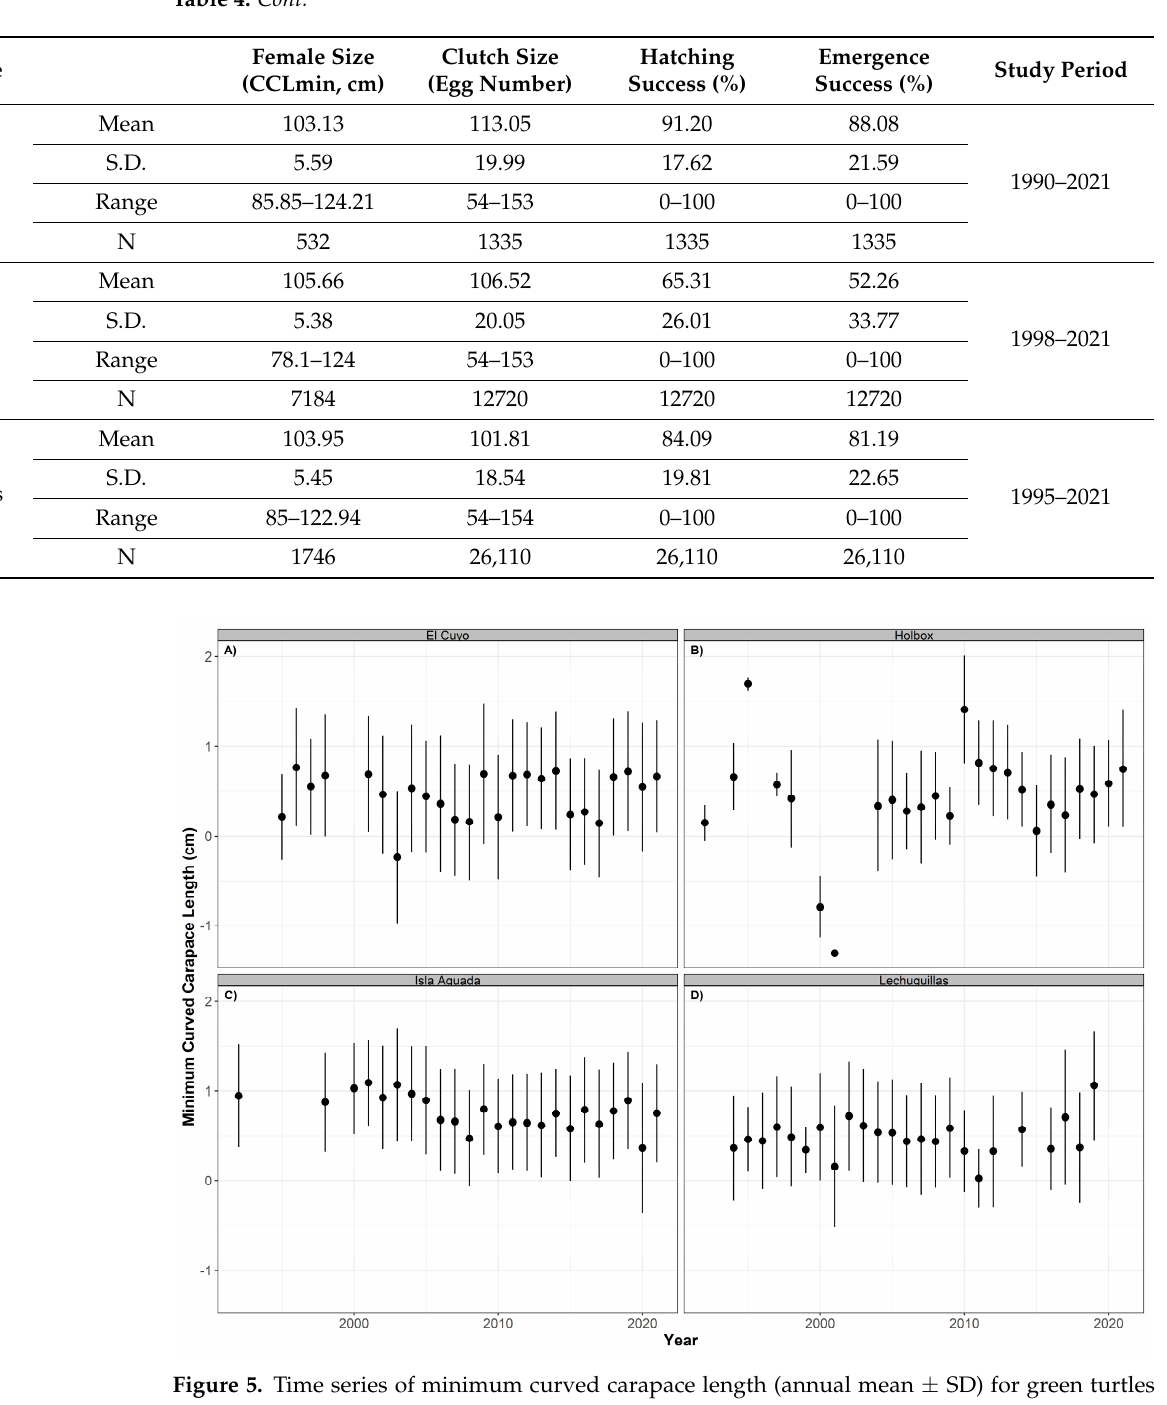
Figure 5. Time series of minimum curved carapace length (annual mean ± SD) for green turtles ( Chelonia mydas ) nesting at El Cuyo ( A ), Holbox ( B ), Isla Aguada ( C ), and Lechuguillas ( D ) from 1990 to 2021.